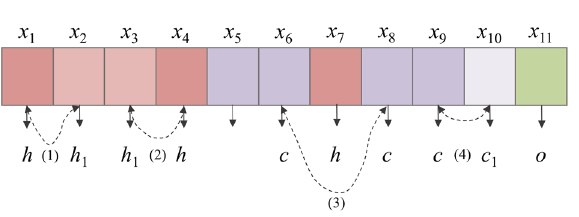
Figure 2. Example of pixels x i ( i = 1–11) and pixel types h , c and o illustrating the proposed labelling strategy. The points (1)–(4) represent transformations of pixel types in the imaging